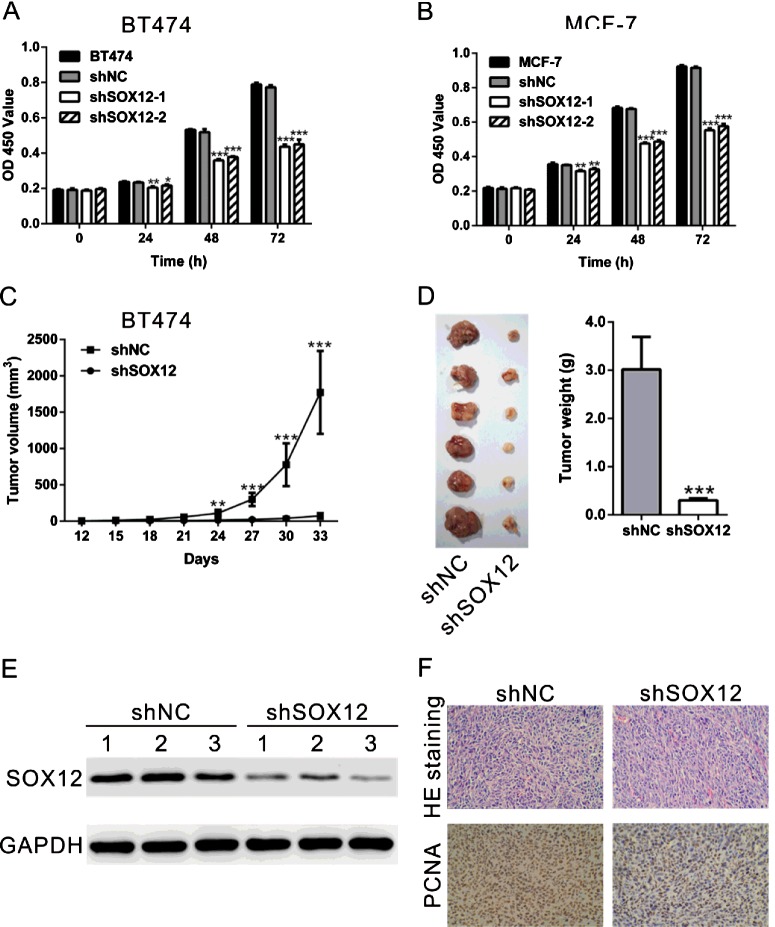
Knockdown of SOX12 suppressed the proliferation of breast cancer cells in vitro and in vivo. (A and B) Knockdown of endogenous SOX12 inhibited the growth of BT474 and MCF-7 cells. (C–F) SOX12 knockdown reduced the growth rate of xenograft breast tumours. BALB/c nude mice were inoculated with BT474 cells stably infected with shNC or shSOX12 virus (n=6). The tumour size was monitored every 3 days and growth curves of xenograft tumours were shown in (C). At 33 days after inoculation, the mice were killed and the tumours were recovered. Images of and weights of xenograft tumours were shown in (D). The expression of SOX12 in xenograft from the nude mice was determined by Western blot (E). Representative images of HE staining and PCNA immunohistochemical staining of xenograft tumours were shown in (F). **P<0.01 and ***P<0.001 compared with shNC.